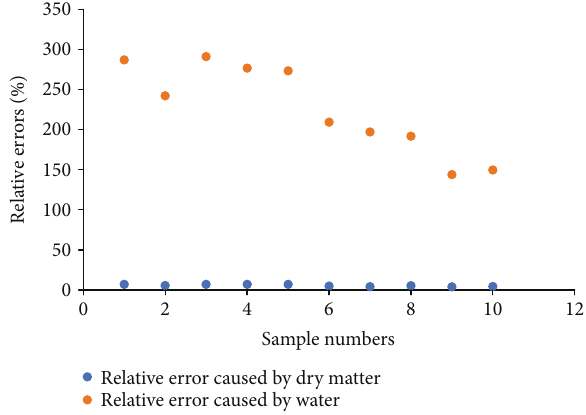
Figure 8: Relative errors caused by water and dry matter. The horizontal and vertical axes represent the sample number and the relative error, respectively, multiplied by a factor of